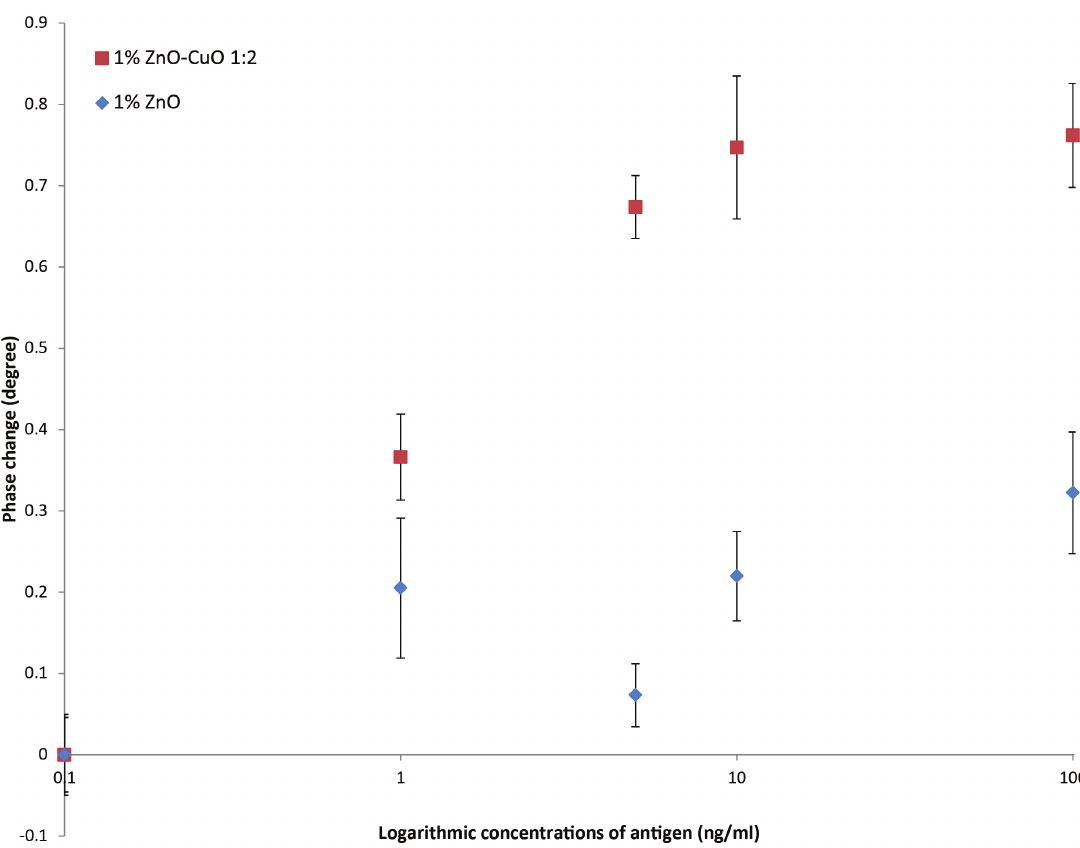
Figure 7. Sensor response to increasing concentrations of CRP added to nano-surfaces with the ratio of 1:2 ZnO-CuO and pure ZnO nano-surfaces (n = 3) at the frequency of 138 Hz with 200 ng capture antibody-standard error bars are